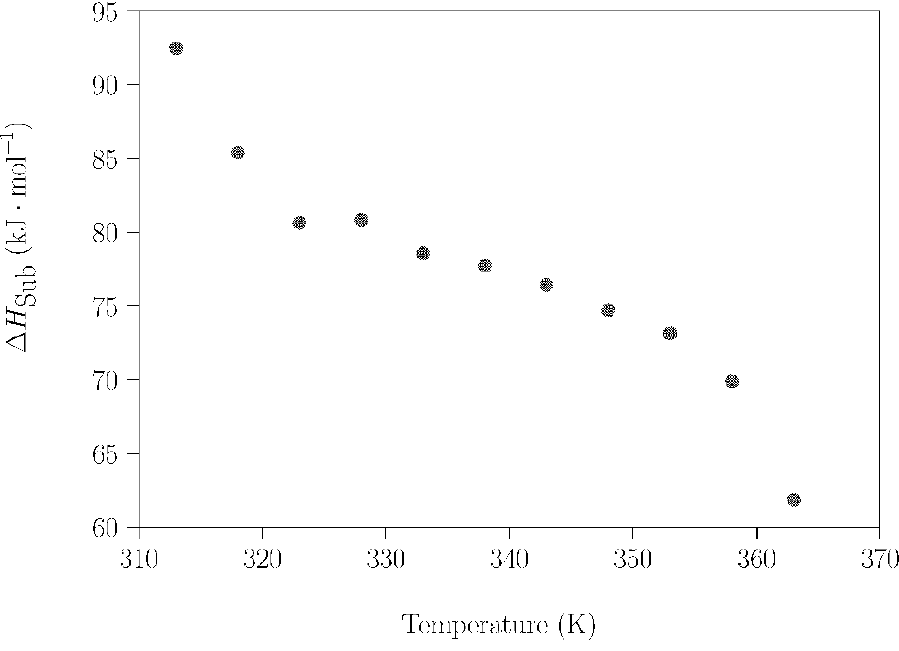
Figure 7. Δ H sub of NPG as a function of the temperature in the range 313–363 K. Figure 7. ∆ H sub of NPG as a function of the temperature in the range 313–363 K. Going one step further, the sublimation of NPG was investigated more precisely, applying the same procedure in a smaller temperature range (313–363 K) to avoid the influence of these phase transitions (experimental results shown in Figures S10 and S11 were used). In this case, the measurements were acquired under isothermal conditions for 20 min every 2.5 K. For this selected temperature range, Figure 8 shows a remarkably linear dependence of ∆ H sub on the temperature; i.e., only the sublimation of NPG takes place. The marked dependence of ∆ H sub on temperature was already noticed by Font et al. [56], although they did not report the temperature variation of the sublimation enthalpy for the whole plastic phase range. In this reference, the authors reported values of ∆ H sub acquired using a calorimetric method with Knudsen effusion cells, and only at two different temperatures close to the solid–solid phase transformation point: i) just before the solid–solid phase transition (311.3 K, ∆ H sub = 87.6 kJ · mol − 1 ); and ii) just after the solid–solid phase transition (318.6 K, ∆ H sub = 75.5 kJ · mol − 1 ). Taking into account the as- sumed associated error of 5%, our experimental values of ∆ H sub for these two temperatures (Figure 7) are in an agreement with these